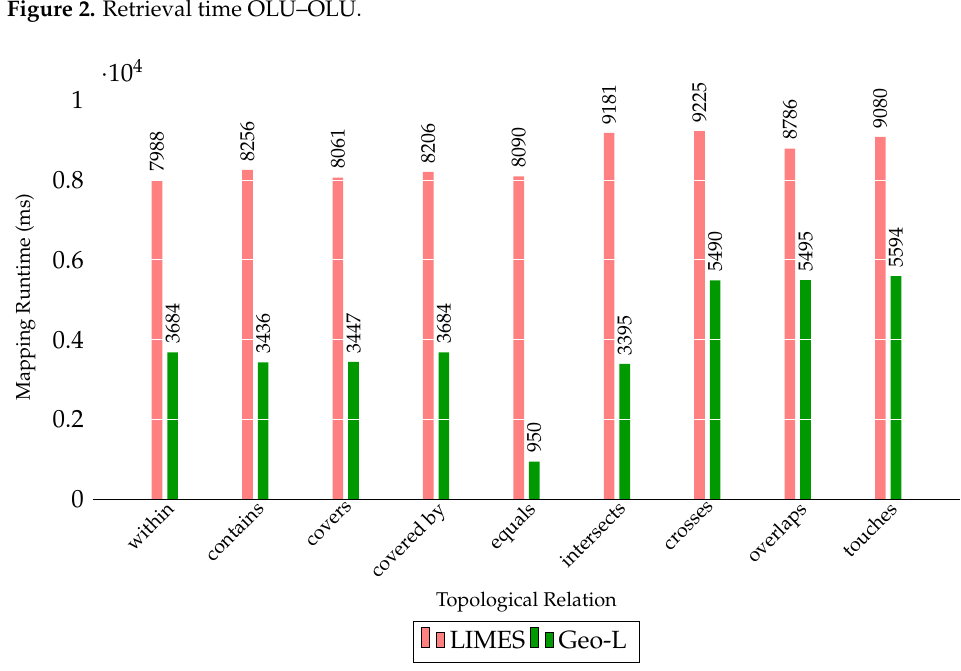
Figure 2. Retrieval time OLU–OLU.